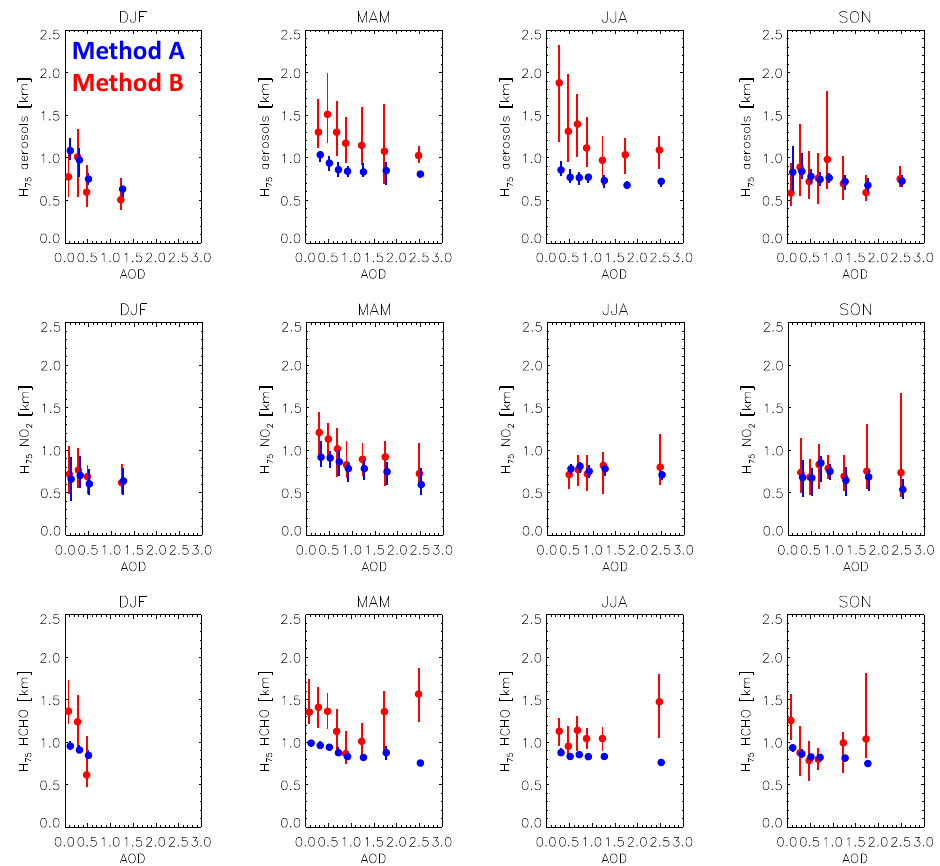
Figure 17. Median values of the characteristic profile height ( H 75 ) for aerosols (upper row), NO 2 (middle row) and HCHO column (bottom row) for a range of AOD bins, specified per season.